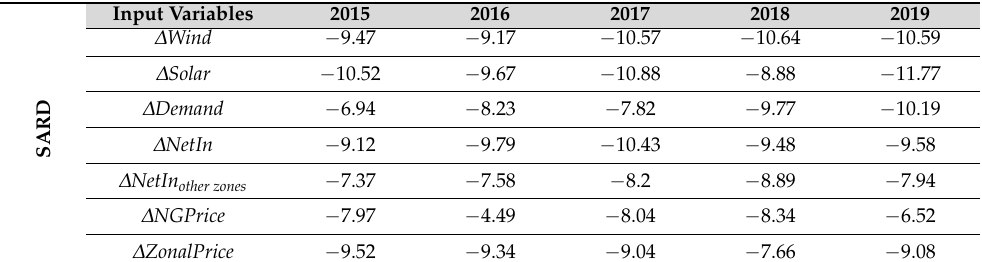
Table A4. Augmented Dickey–Fuller test statistics in 1st difference; SARD.